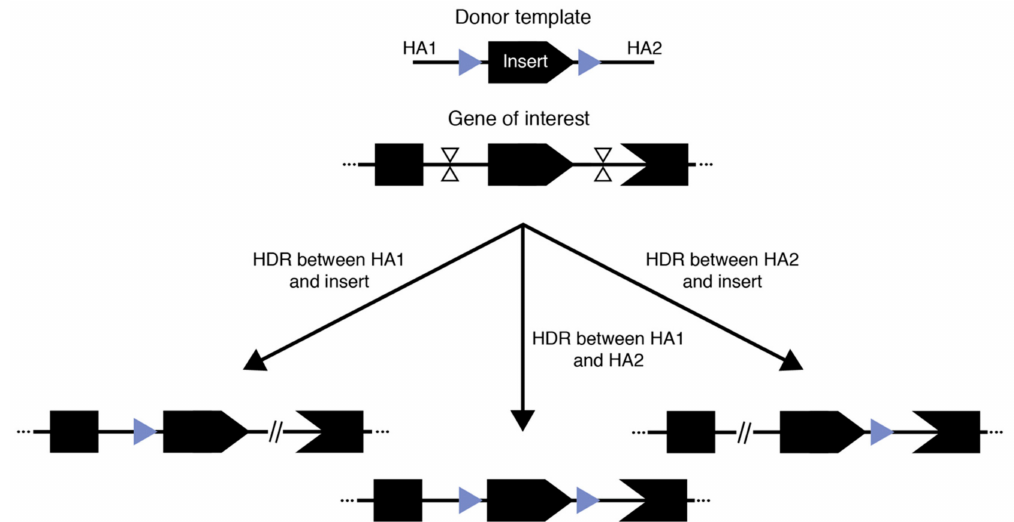
Figure 2. Three competing outcomes from generating floxed alleles with a large